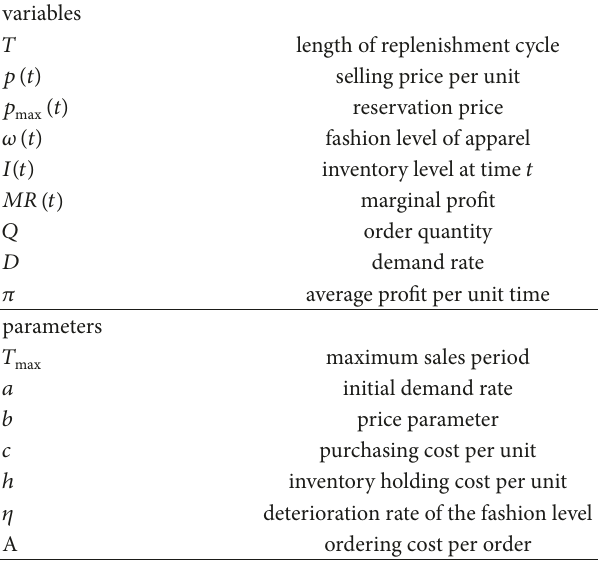
Table 1: Notations and